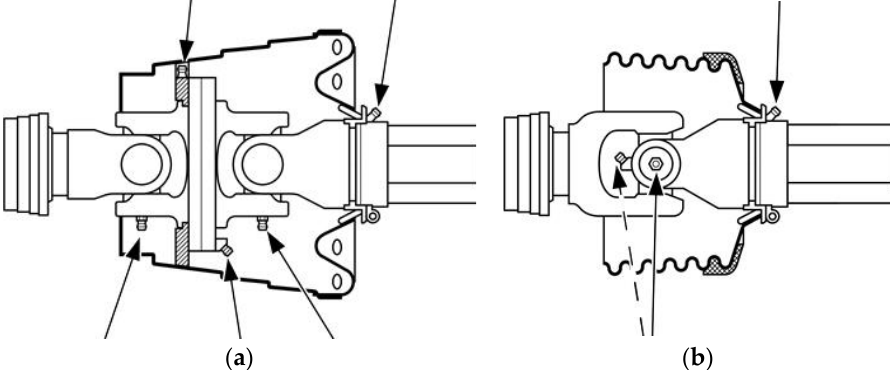
Figure 1. Comparison of a wide ‐ angle joint ( a ) and a standard joint ( b ) with their respective lubrication zerks.